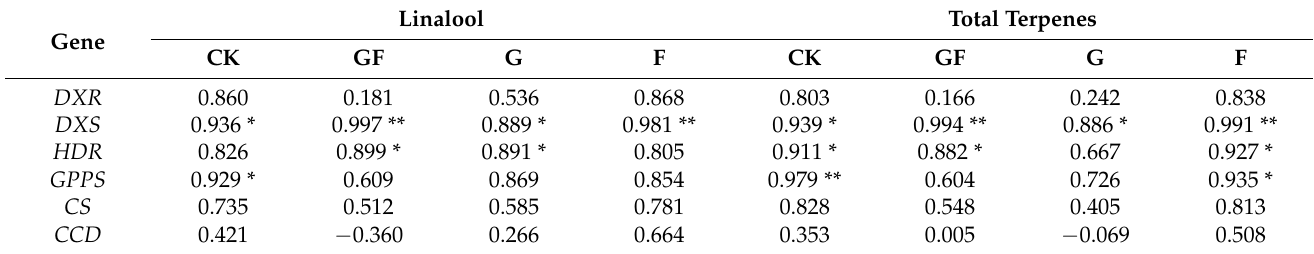
levels for six genes in ‘Hanxiangmi’ table grape. * and ** indicate significance at p < 0.05 and p < 0.01,